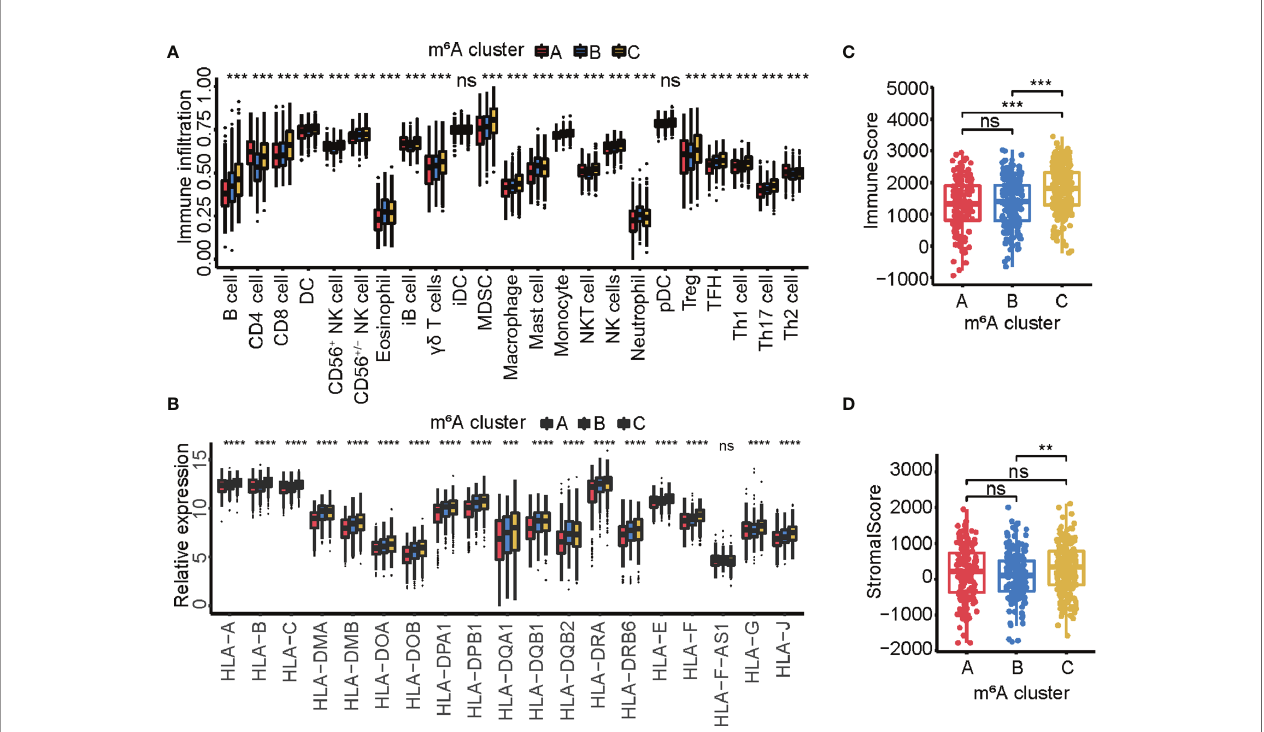
FIGURE 3 | The immune landscape in three m 6 A modi fi cation patterns. (A) The relative abundance of 23 tumor-in fi ltrating immune cell types in three m 6 A modi fi cation patterns. The upper and lower ends of the boxes represented interquartile range of values. The lines in the boxes represented median value, and black dots showed outliers. The asterisks represented the statistical p -value (** p < 0.01; *** p < 0.001). (B) The expression of MHC molecules in three m 6 A modi fi cation patterns. The upper and lower ends of the boxes represented interquartile range of values. The lines in the boxes represented median value, and black dots showed outliers. The asterisks represented the statistical p -value (ns p > 0.05; ** p < 0.01; *** p < 0.001). (C) Box plot showing the immune scores of the three m 6 A clusters. (D) Box plot showing the stromal score of the three m 6 A